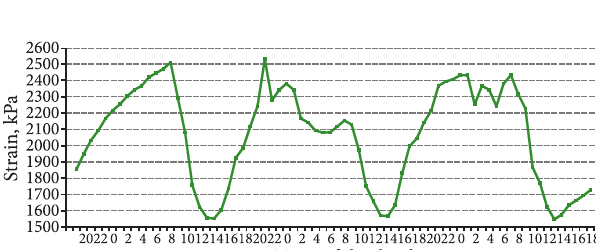
Table 3. Results of the mode of deformation research for scheme in Fig. 4 Model number: Layer Max compressive stress, Max tensile stress, Deflection, number Fig. 4: load a Fig. 4: load b Fig. 4: load c